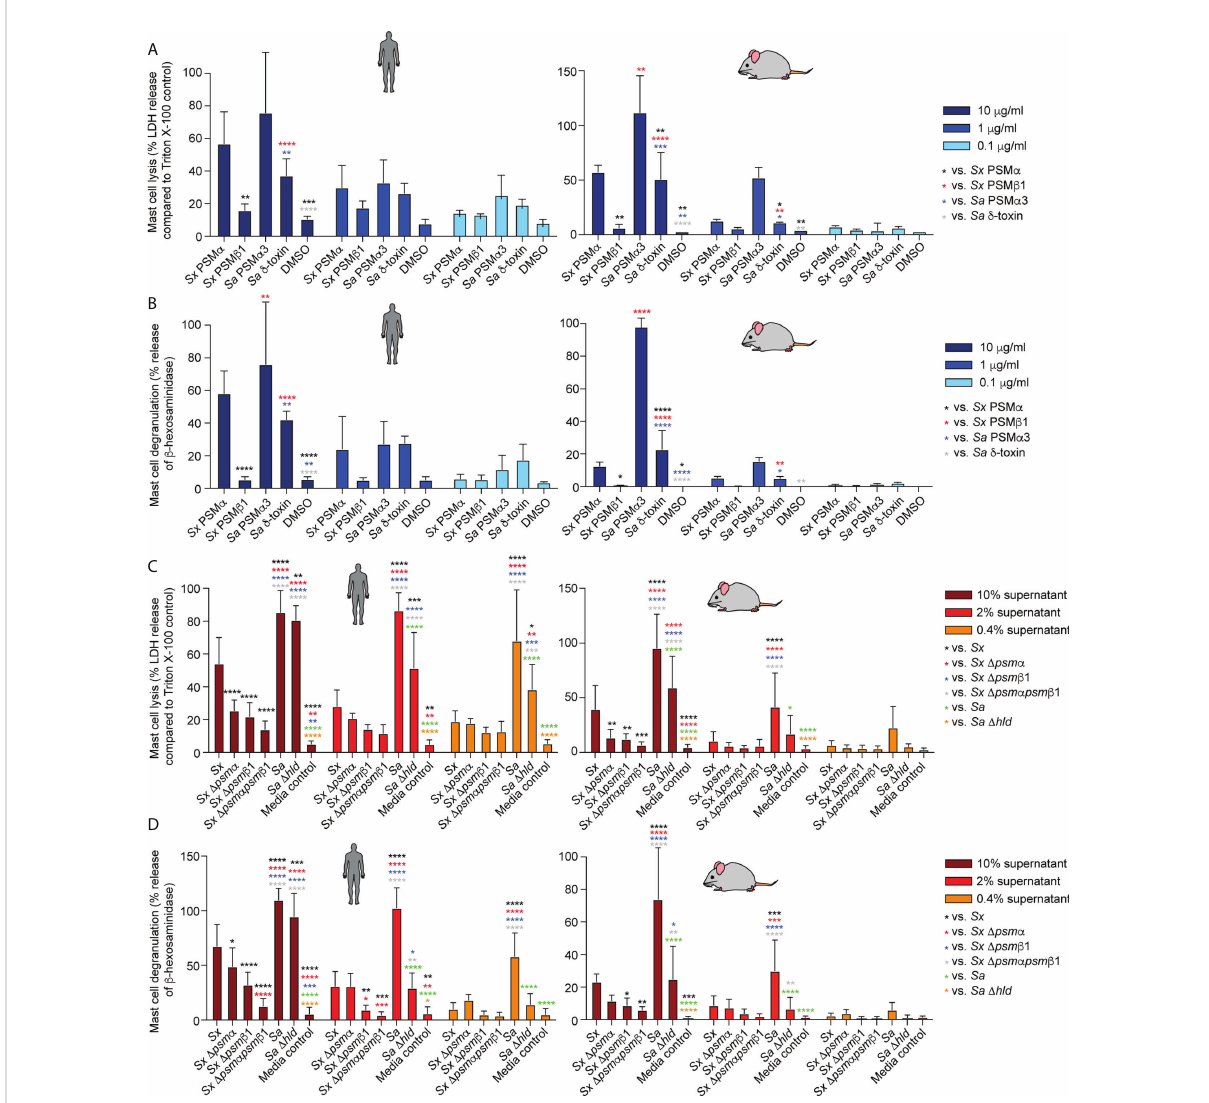
FIGURE 6 Mast cell degranulation by S. xylosus PSMs. Human and mouse mast cell degranulation and lysis by pure PSM peptides (A, B) and culture fi ltrates (C, D) of S. xylosus AG14 WT and isogenic psm mutants is shown. Statistical analysis is by 1-way ANOVA with Tukey ’ s post-tests. *, p<0.05; **, p < 0.01; ***, p < 0.001; ****, p < 0.0001; Error bars show the mean ± SD. Mouse and human schemes are from